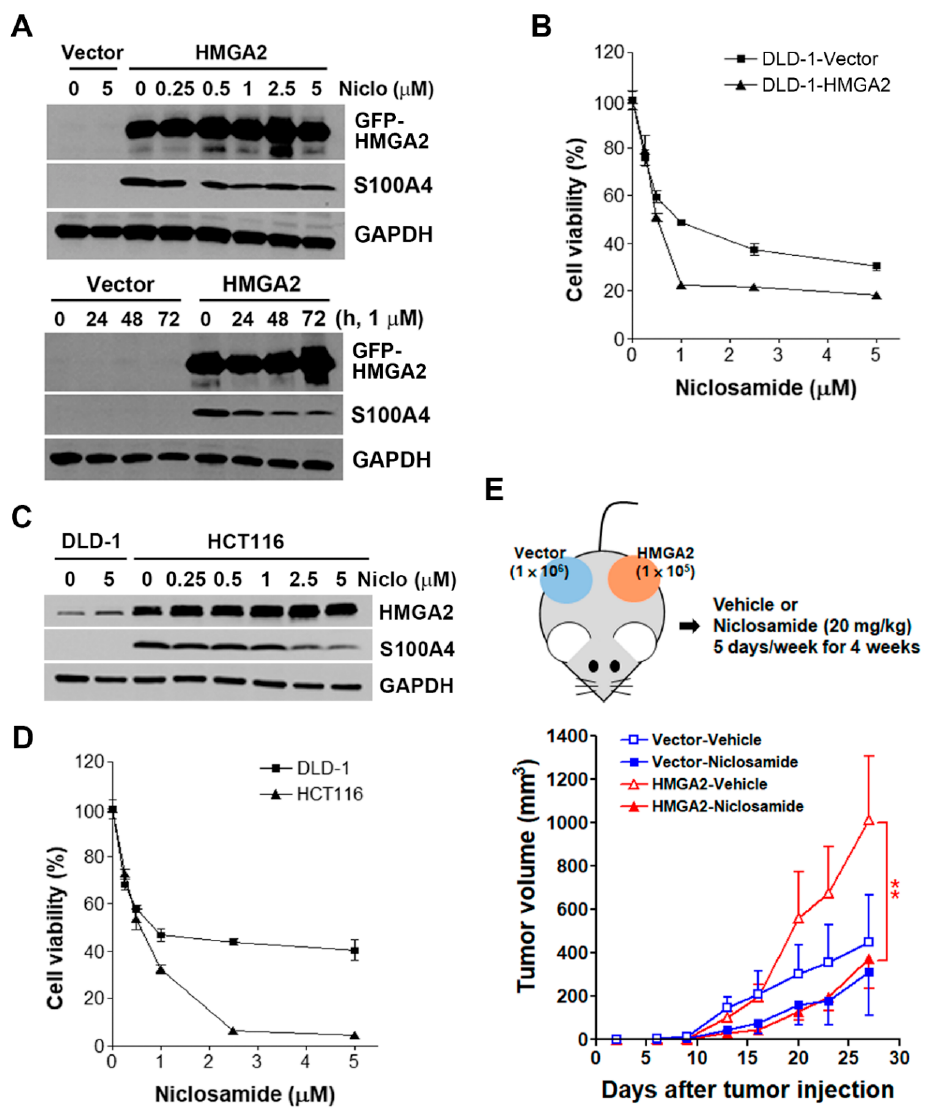
Figure 7. E ff ect of niclosamide on S100A4 expression and cancer growth in HMGA2-overexpressing colorectal cancer cells. ( A ) DLD-1-Vector and DLD-1-HMGA2 cells were treated with various doses of niclosamide for 48 h (the upper part), or 1 μ M niclosamide for 1–3 days (the lower part). Whole cell lysates were prepared and subjected to Western blot analysis; ( B ) DLD-1-Vector and DLD-1-HMGA2 cells were treated with various doses of niclosamide for 72 h. The cell viability was analyzed by an MTT assay; ( C ) the protein expression of HMGA2 and S100A4 in DLD-1 and HCT116 cells was analyzed by Western blot analysis; ( D ) DLD-1 and HCT116 cells were treated with various doses of niclosamide for 72 h. The cell viability was analyzed by an MTT assay; ( E ) DLD-1-Vector (1 × 10 6 ) and DLD-1-HMGA2 (1 × 10 5 ) cells were subcutaneously injected into the right and left flank of nude mice. Then, mice received vehicle [5% DMSO in phosphate-bu ff ered saline (PBS); n = 5] or niclosamide (20 mg / kg; n = 5) for four weeks. Tumor volumes were measured twice per